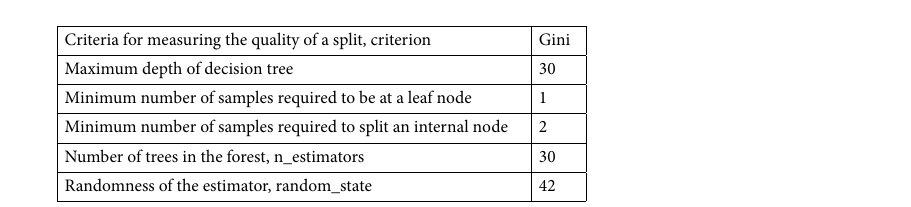
Number of neighbors, n_neighbors Weight function used in prediction, weights Algorithm used to compute the nearest neighbors, algorithm Leaf size passed to BallTree or KDTree, leaf_size The distance metric to use for the tree, metric Power parameter for the Minkowski metric, p Table 2. Setting parameters for KNN.